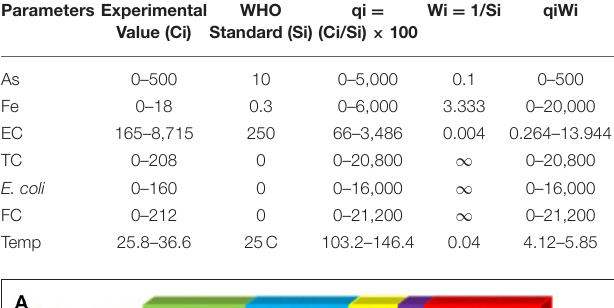
TABLE 5 | Range of computed value in different steps during WQI calculation in tested PoS. Parameters Experimental Value (Ci)